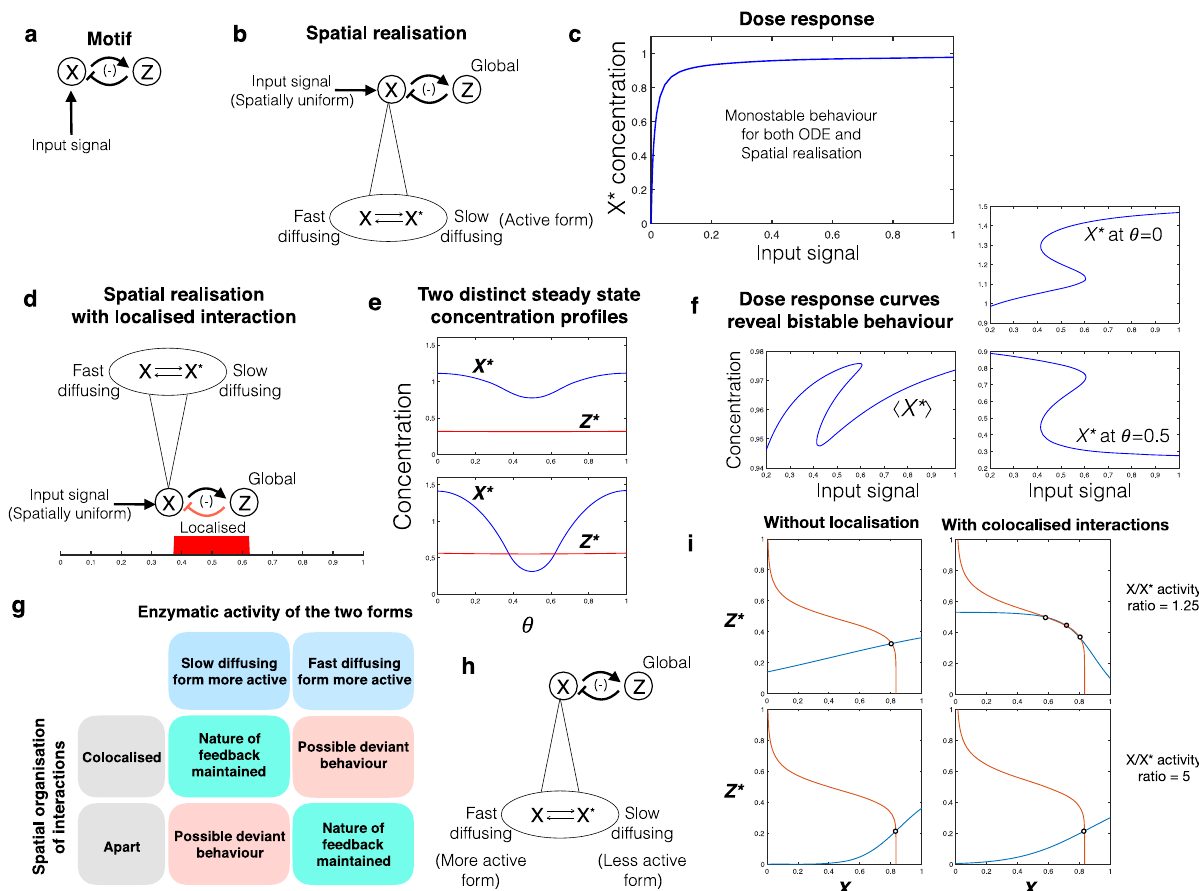
Fig. 7 Inferring the nature of a feedback motif. a Schematic of the negative feedback motif (purely temporal realisation). b Schematic of the spatial realisation with the X node involving interconverting forms with different diffusivities. c Bifurcation analysis of the ODE model shows monostable behaviour. The corresponding PDE model exhibits bifurcation characteristics identical to that of the ODE model, for a uniform input signal. d Schematic indicating localisation of one of the interactions: inhibition of X by Z. e This system can exhibit bistability. The two co-existing stable steady state pro fi les for a fi xed input level are shown here ( X * blue curves, Z * red curves). f Bifurcation analysis of the PDE model reveals bistable behaviour. However, if the domain average is used to characterise the steady state(s), the contrast between the steady states may not be signi fi cant, and a transition from one branch to the other may be consequently obscured (left panel). The same steady state can be characterised as a high X * or a low X * if a local measure of the output is used to characterise the steady state (two right panels). g – i Characterising feedback behaviour in circuits with two diffusivity nodes and localisation of interactions. g Assessing the impact of different types of localisation in a feedback circuit containing a two diffusivity node. The type of circuit is depicted in ( b ). This is depicted in the table which is organised along two axes-the localisation of the interactions (whether in the same location or different locations) and the relative activity of the slow and fast diffusing forms. The table is relevant to both negative and positive feedback and highlights scenarios which can lead to deviant feedback behaviour (see text). h depicts the speci fi c instance of a negative feedback circuit where the fast diffusing form is more active (but both forms are active). i Nullcline-based analysis (see Supplementary Information) shows that when interactions are co-localised, in certain ranges of activity ratios, this feedback circuit can exhibit bistability (crossing of nullclines at three points: red curve X-nullcline, blue curve Z